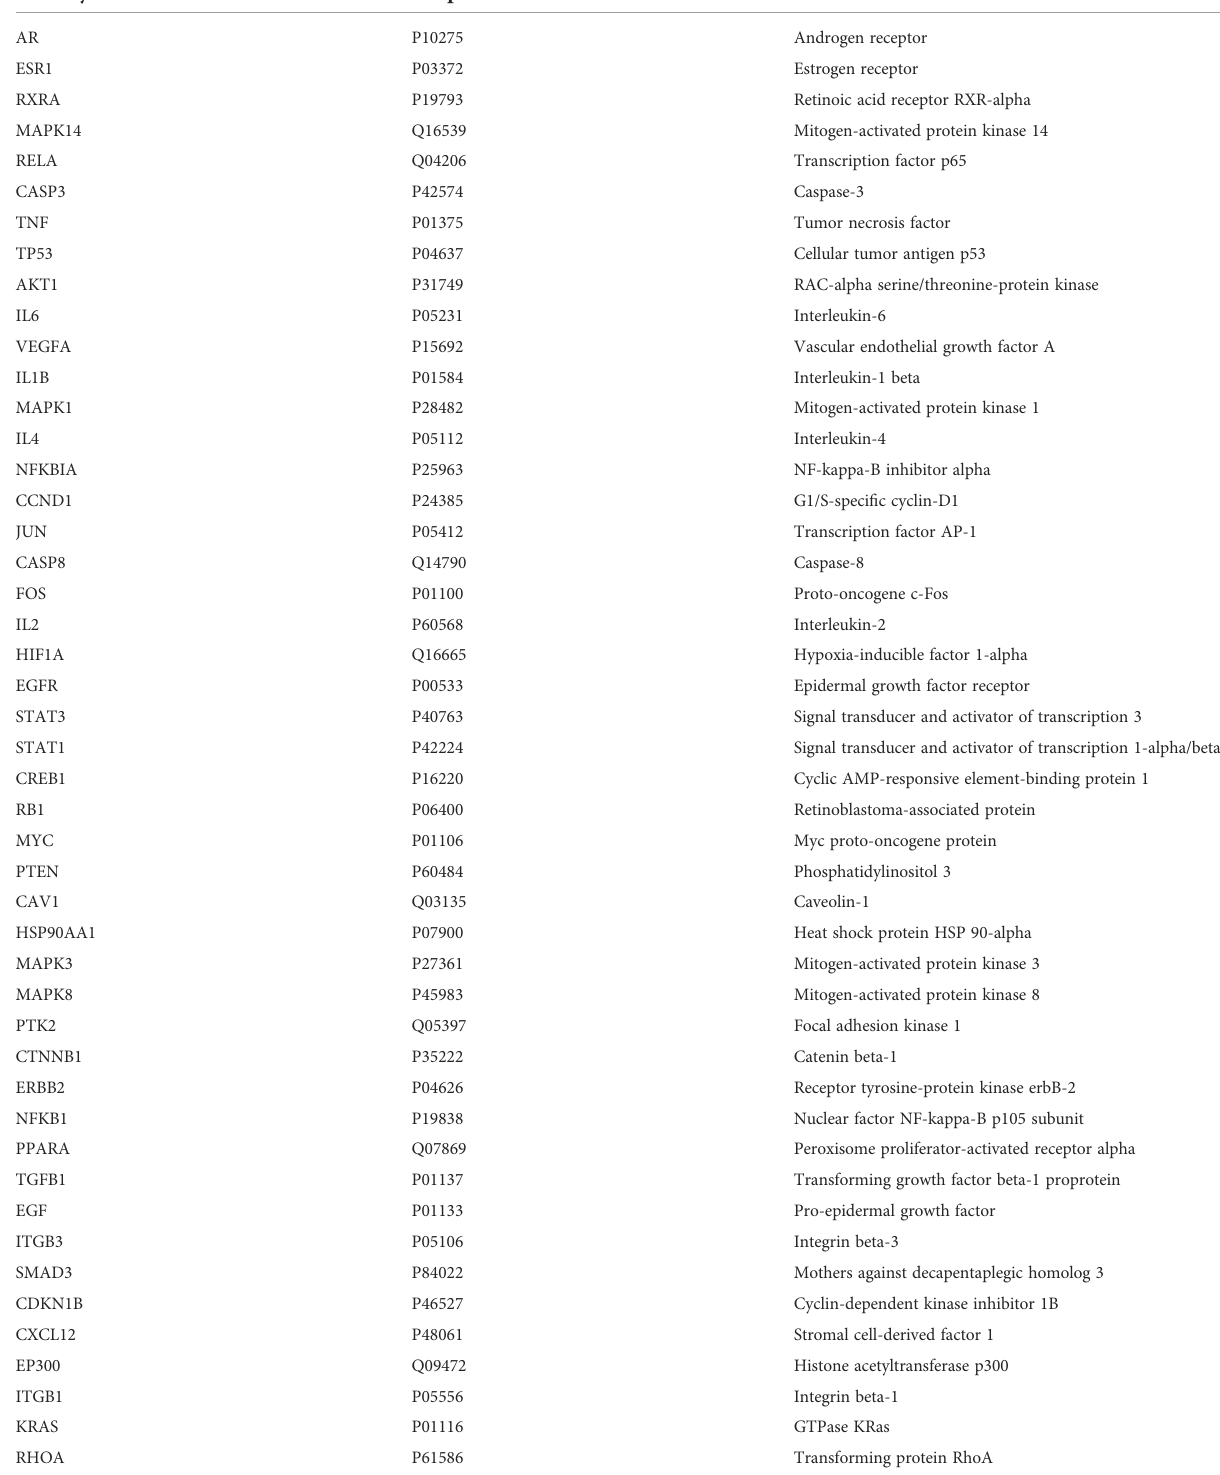
TABLE 2 Forty-seven HBV-associated HCC targets a